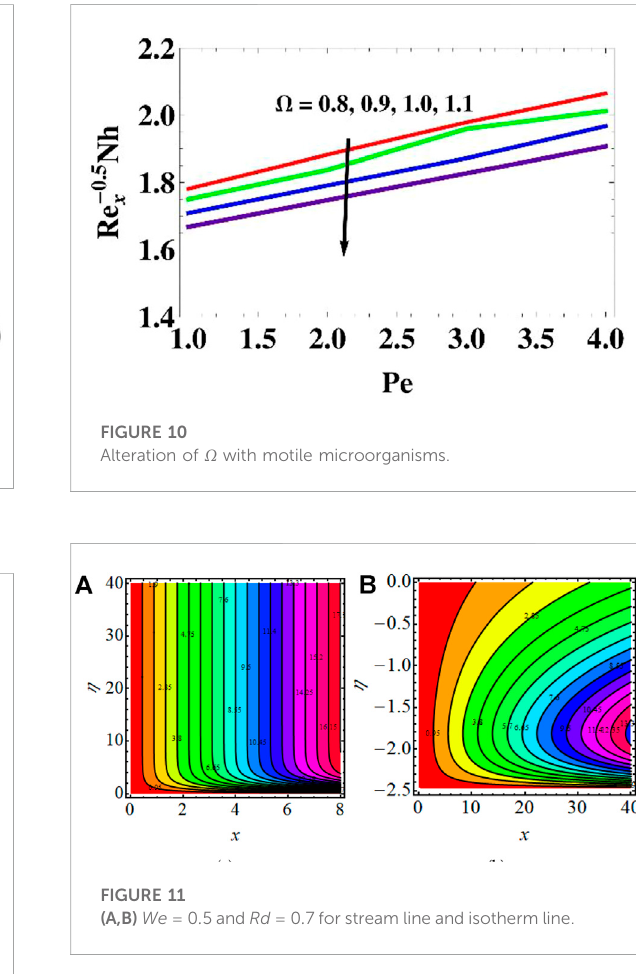
FIGURE 8 Alteration of ε with Nusselt number.